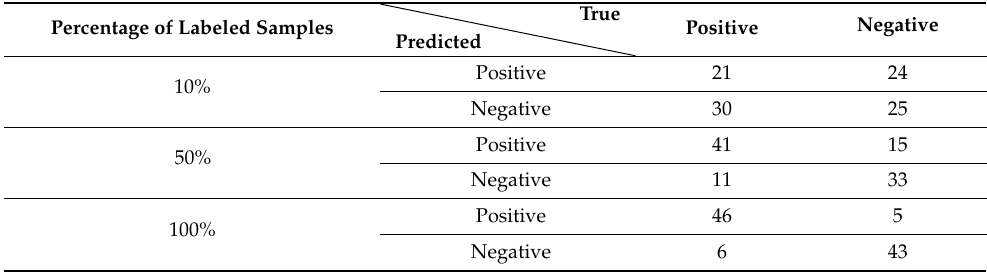
Table 3. Analysis of model prediction results and physician examination